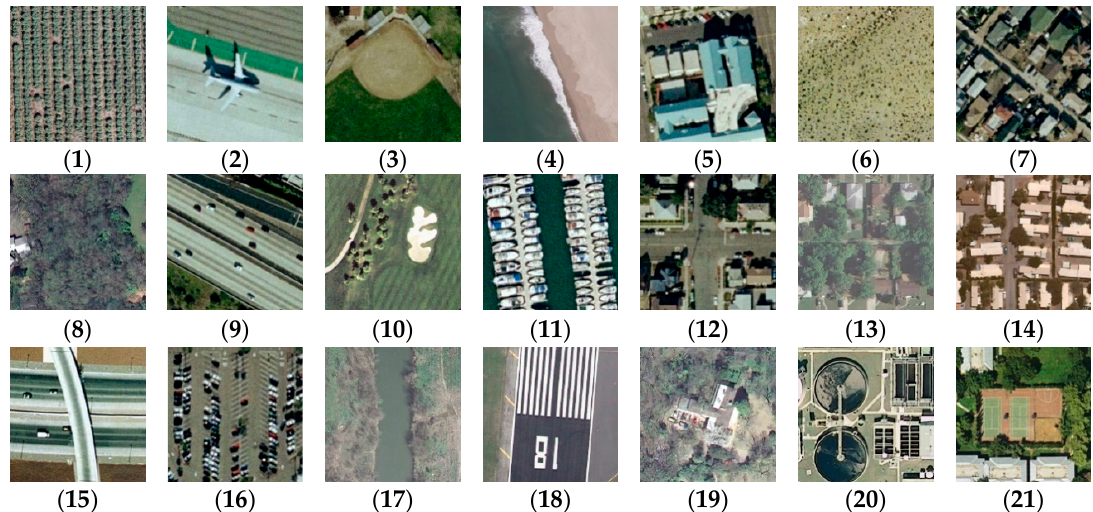
Figure 1. Class representatives of the UC Merced dataset: ( 1 ) agricultural; ( 2 ) airplane; ( 3 ) baseball diamond; ( 4 ) beach; ( 5 ) buildings; ( 6 ) chaparral; ( 7 ) dense residential; ( 8 ) forest; ( 9 ) freeway; ( 10 ) golf course; ( 11 ) harbor; ( 12 ) intersection; ( 13 ) medium residential; ( 14 ) mobile home park; ( 15 ) overpass; ( 16 ) parking lot; ( 17 ) river; ( 18 ) runway; ( 19 ) sparse residential; ( 20 ) storage tanks; and ( 21 ) tennis court.